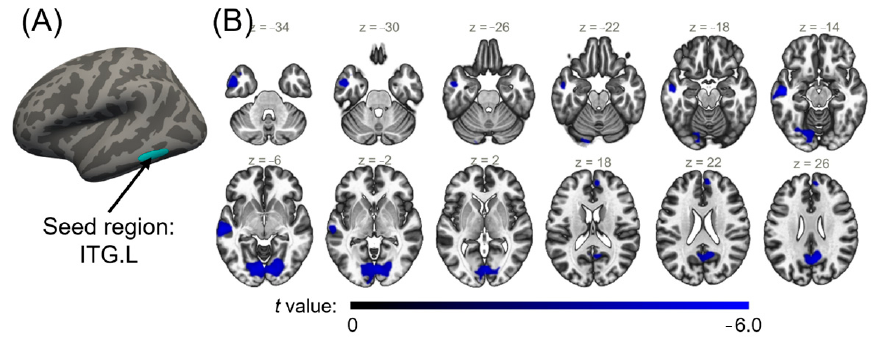
Figure 4. Cortical thickness of the left inferior temporal cortex exhibited a signi fi cant “group × age” interaction e ff ect. ( A ) Signi fi cant interaction e ff ect of “group × age” in the left inferior temporal cor- tex; ( B ) age slopes of regional mean cortical thickness in the left inferior temporal cortex in CLP and HC. Gender was regressed out as a covariate, and signi fi cance was set at cluster-wise p < 0.05 using Monte Carlo simulation with 5000 iterations.